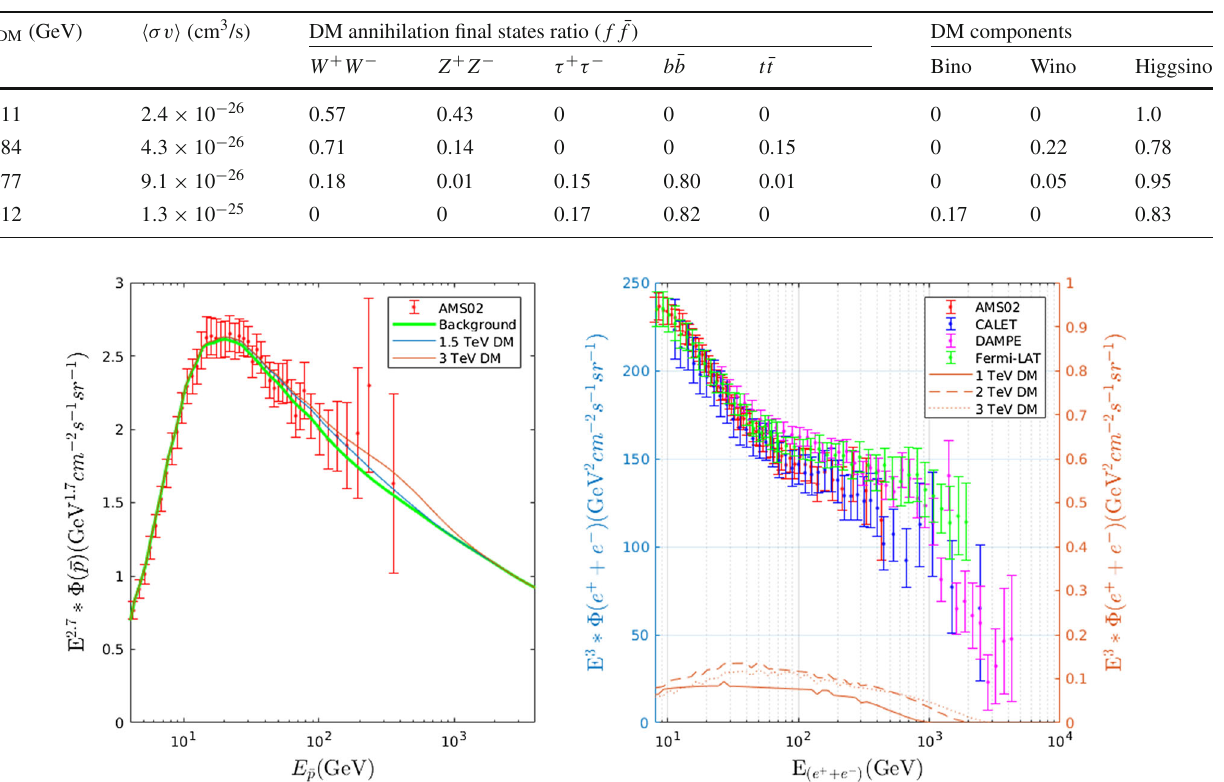
the AMS-02 [31], the CALET [32], the DMAPE [2] and the Fermi-LAT [33] data (read the left Y-axis) as well as the 1–3 TeV neutralino dark matter annihilation contribution (read the right Y-axis) are shown. The errors of the data are 1 σ statistical and systematic